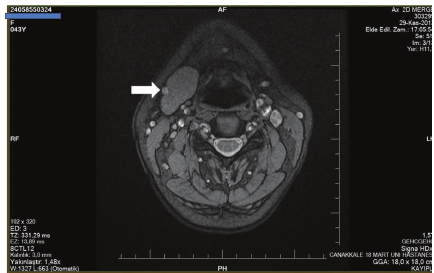
Figure 4: Magnetic resonance image axial sections demonstrate absence of left submandibular gland in the second case. White arrow shows the right submandibular